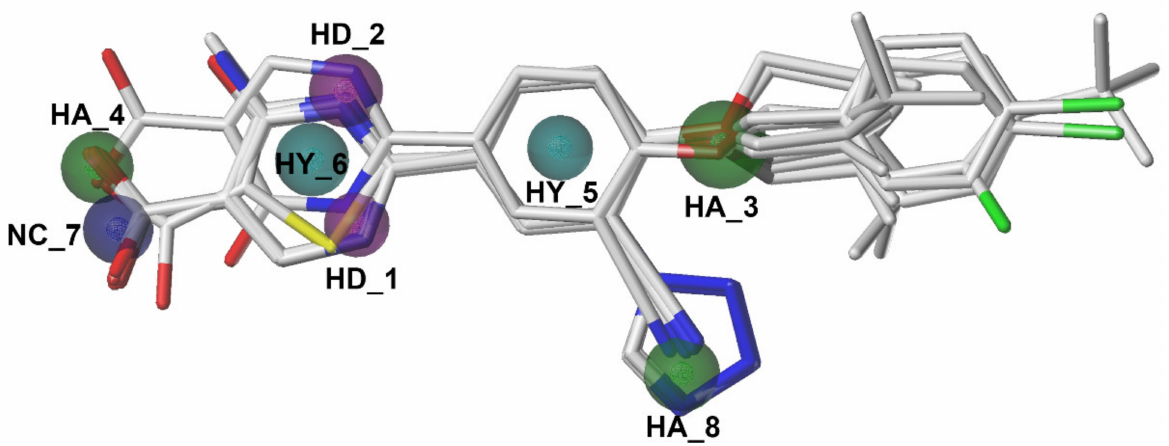
Figure 7. The optimal pharmacophore model. Green, magenta, cyan, and blue spheres represent hydrogen-bond acceptor atoms (HAs), hydrogen-bond donor atoms (DAs), hydrophobes (HYs), and negative centers (NCs), respectively.